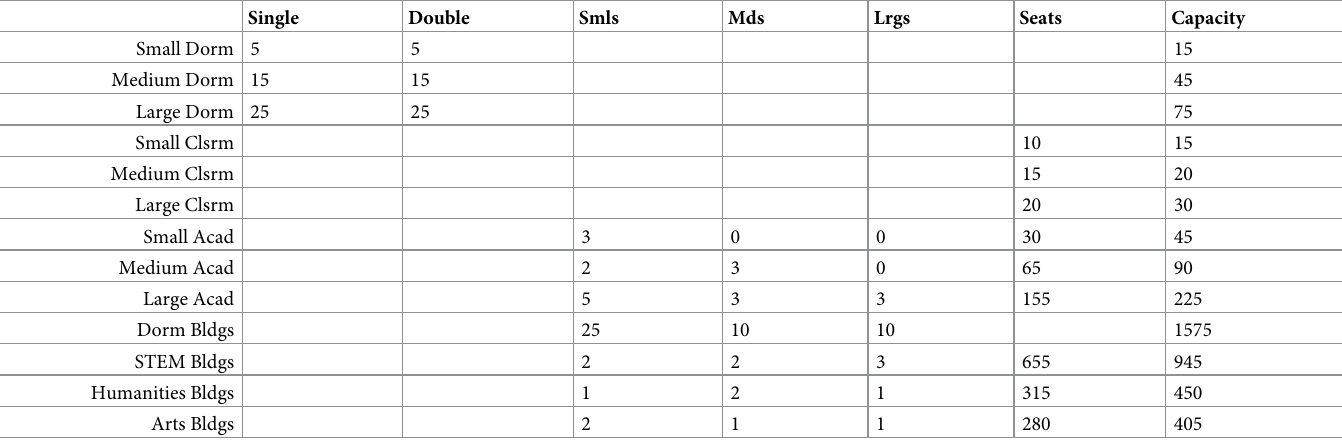
Table 2. At the top, counts for the number of single and double dorm rooms, the number of seats in classrooms. In the middle, the number of classrooms in each type of building. On the bottom, the number of each type of building. Single Double